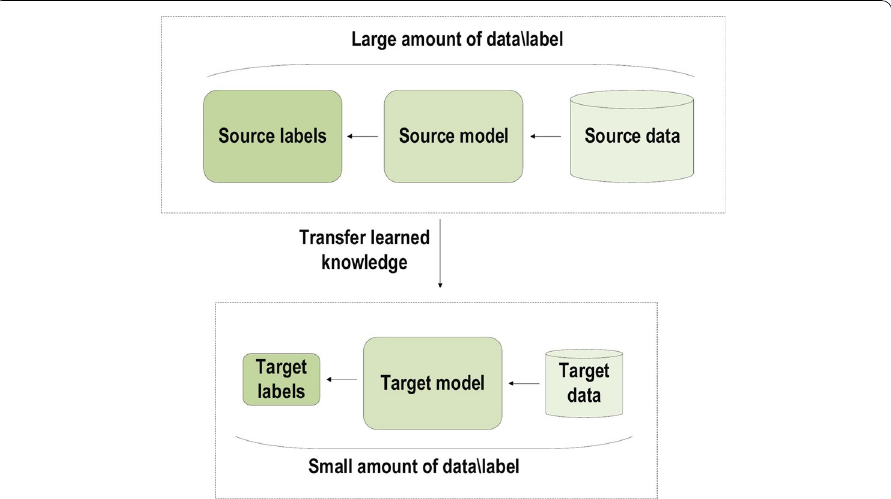
Fig. 28 The conceptual diagram of the TL